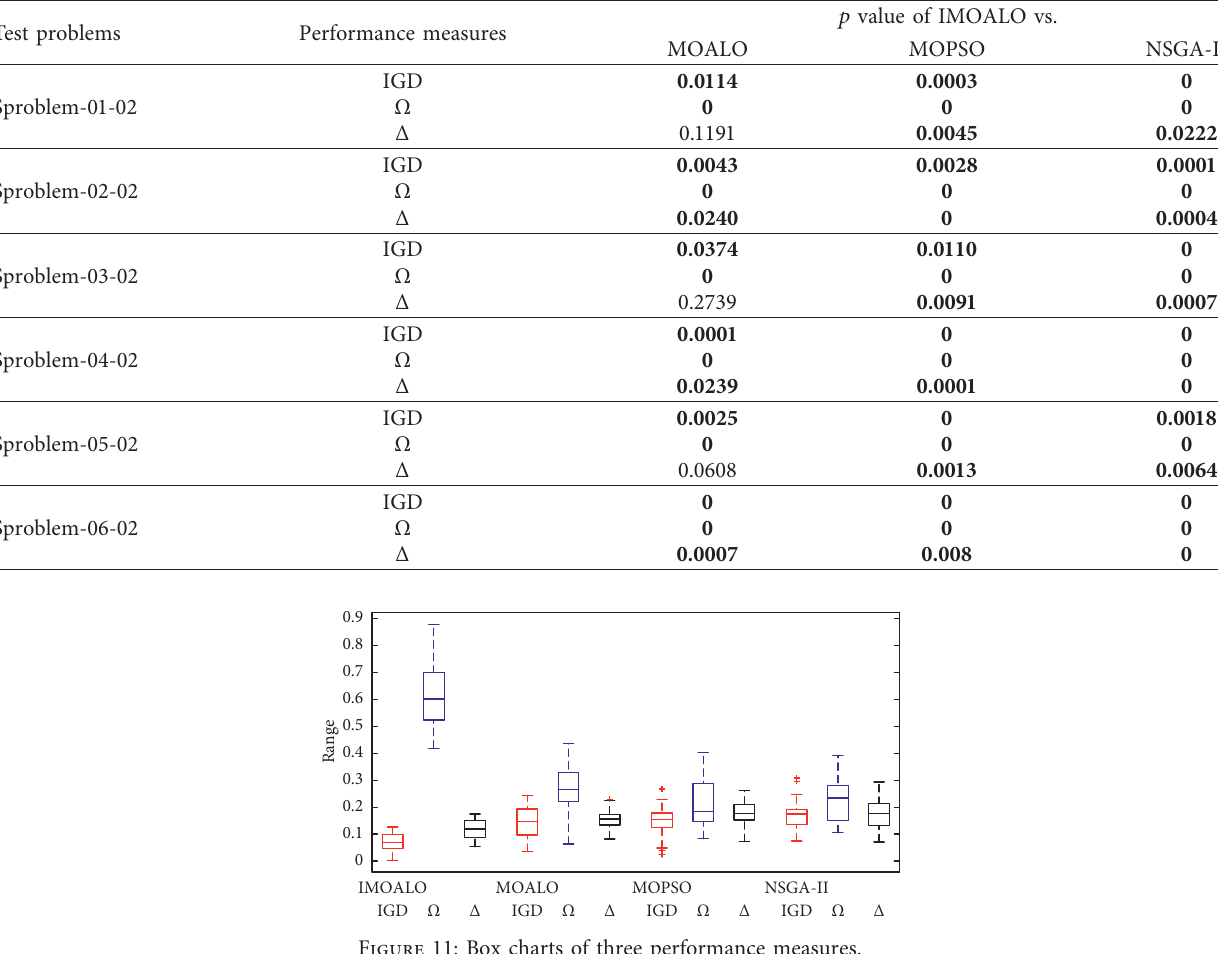
Figure 11: Box charts of three performance measures.